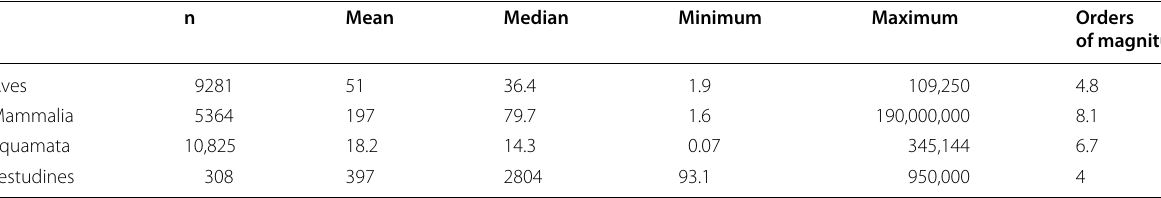
n number of species with data. Means are back transformed from logarithms =